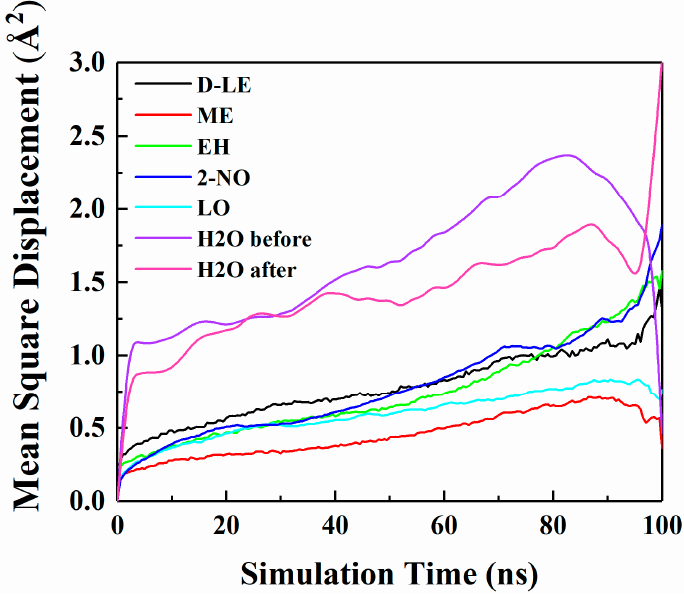
Figure 8. MSD curves of H 2 O and five flavor organic molecules in PE. Table 7. Di ff usion coe ffi cients of O 2 and H 2 O before and after adsorption of PE by flavor.